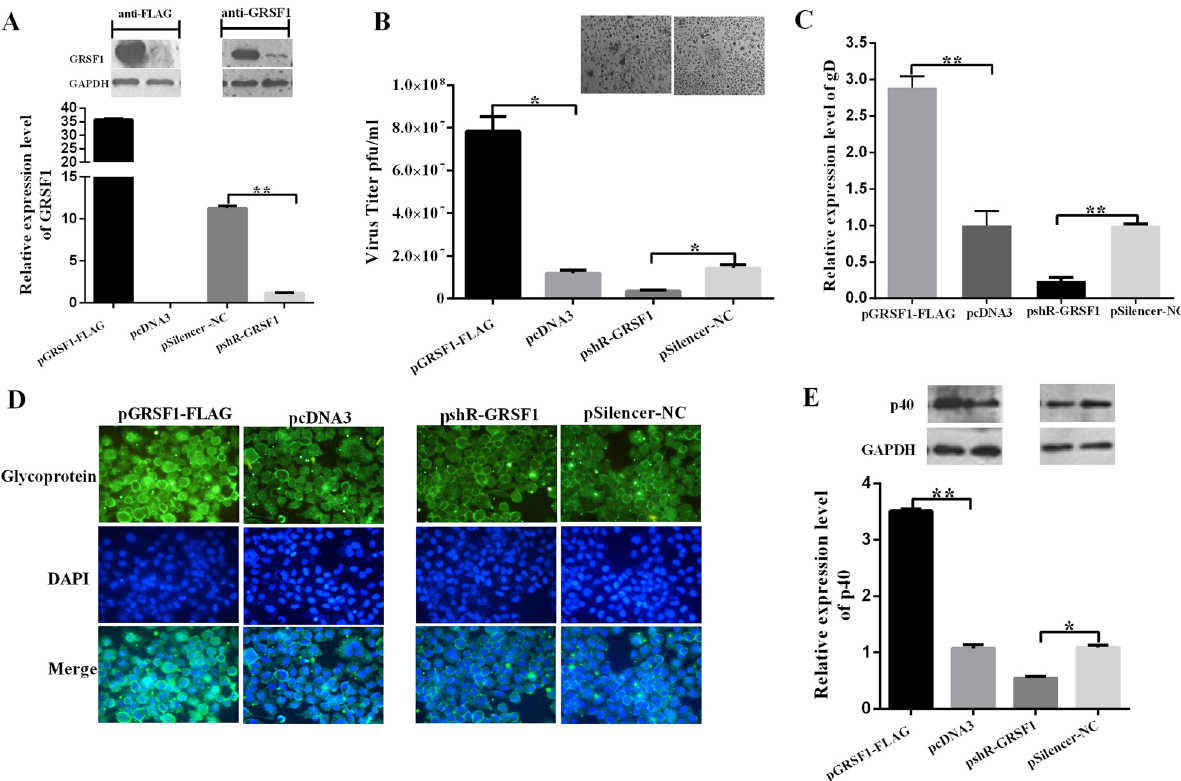
Figure 5. GRSF1 promotes HSV-1 replication. ( A ) GRSF1 protein levels were detected by western blot of extracts from HeLa cells that had been transfected with pGRSF1-FLAG and pshR-ICP4. GAPDH protein was used as an endogenous control. ( B ) HeLa cells were transfected with pGRSF1-FLAG, pshR-GRSF1 and their respective controls for 24 h followed by HSV-1 infection for 24 h. The supernatant was harvested at 24 h.p.i., and normal HeLa cells were infected. These data represent the mean values ± SD of at least three independent experiments. ( C ) The expression level of the gD gene was detected by qPCR under GRSF1 overexpression and knockdown conditions. These data represent the mean values ± SD of at least three independent experiments (n = 3). ( D ) Immunofluorescence was used to detect HSV-1 replication via the HSV-1 glycoprotein in HeLa cells under GRSF1 overexpression and knockdown conditions. ( E ) A western blot was used to detect HSV-1 replication in the presence of p40 under GRSF1 overexpression and knockdown conditions in HeLa cells. GAPDH protein was used as an endogenous